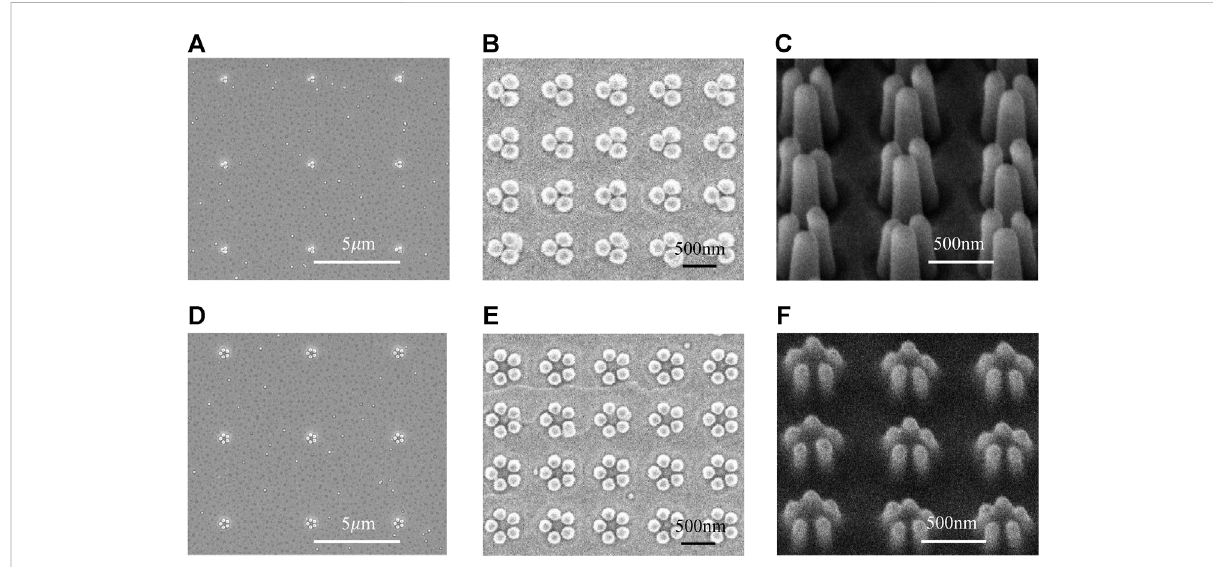
FIGURE 1 SEM images of trimer or pentamer Au nano fi nger arrays. (A) Top-view SEM image of trimer Au nano fi nger arrays with lattice constant of 5 μ m. Scale bar: 5 μ m. (B) Top-view SEM image of trimer Au nano fi nger arrays with lattice constant of 670 nm. Scale bar: 500 nm. (C) Oblique-view SEM image of magni fi ed trimer Au nano fi nger arrays with 500 nm scale bar. (D – F) Corresponding SEM images for pentamer Au nano fi nger arrays.